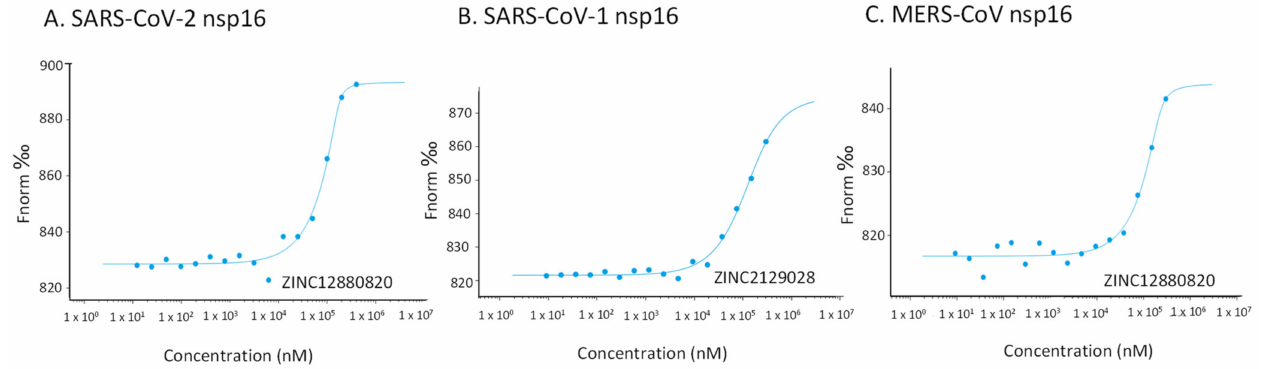
Figure 4. Representative examples of binding of the high-fidelity candidates to nsp16 of SARS-CoV-2